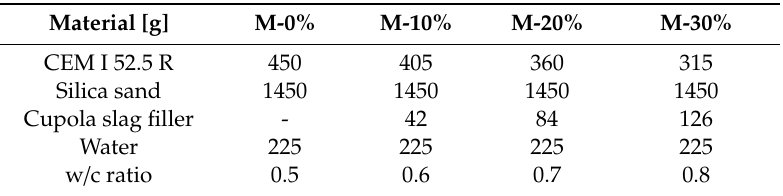
Table 4. Mix proportions of the mortars